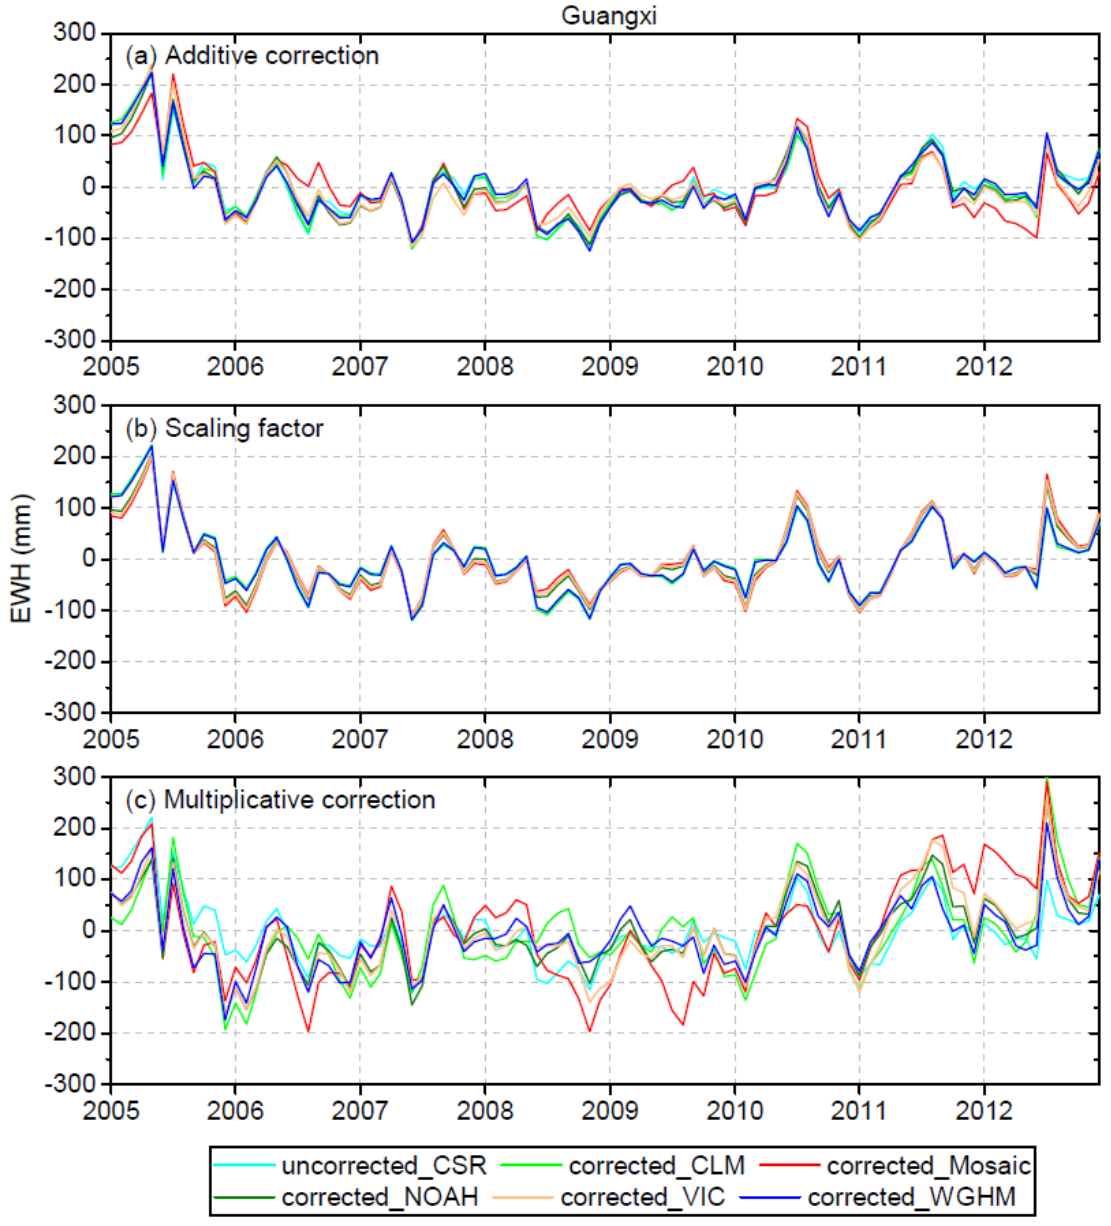
Figure 7. The same as Figure 6, but for Guangxi. Table 3. Statistics of r, RMSE and Nash–Sutcliffe efficiency coefficient (NSE) between leakage- corrected and in situ TWS, and between mascon-based and in situ TWS. All the correlations (r) are evaluated using a two-sided 1% level significance (i.e., p < 0.01).